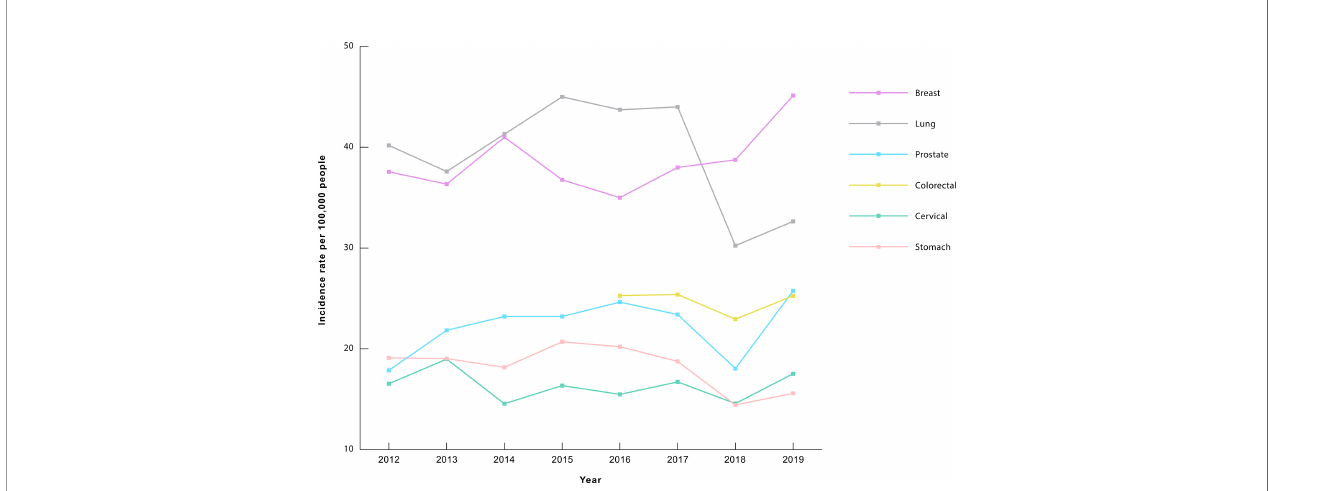
FIGURE 4 | Trends in the incidence of frequently encountered cancers (2012-2019) in Armenia, rate per 100,000 people a . a Data are adapted from the Statistical Yearbook of Armenia: Health and Healthcare, for the years 2014-2020 (3, 28,